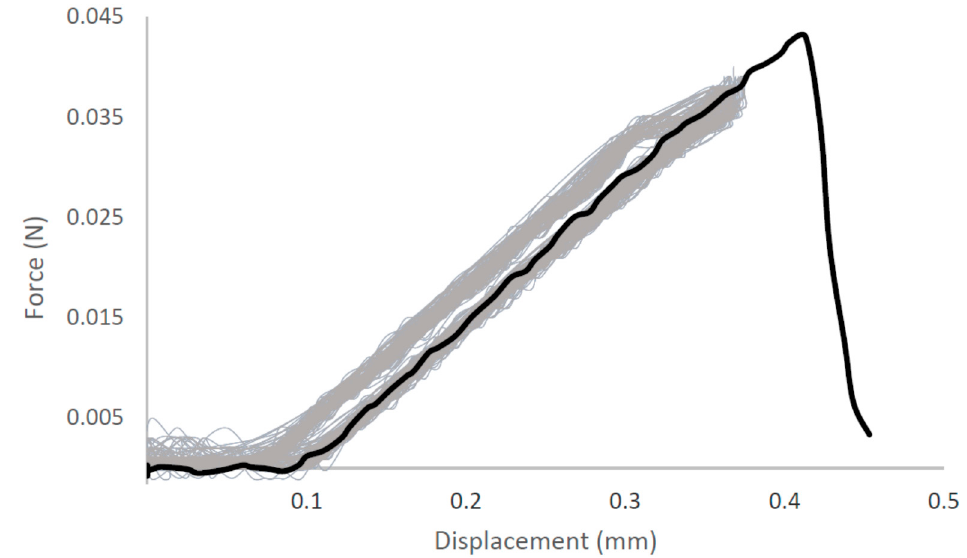
Figure 2. A 19 mm fiber spun from aqueous solution repeatedly cycled 99 times at 5 mm/min to 80% maximum load and then tested to failure.